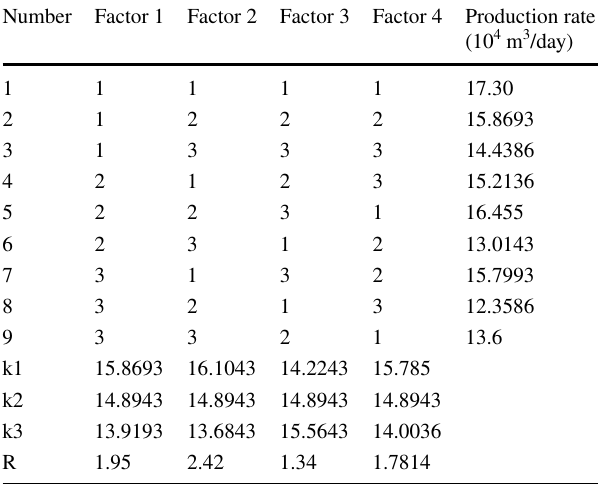
Table 6 Orthogonal experiment result table L